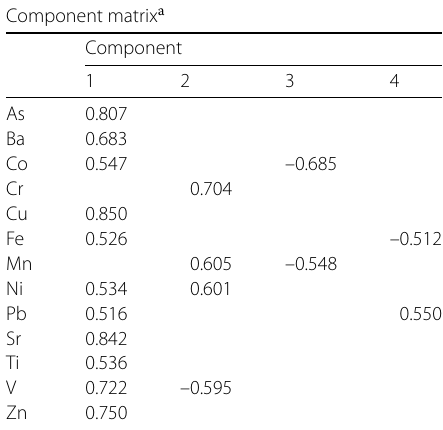
Table 7 Component matrix for surface water samples received from Akcay River Component matrix a